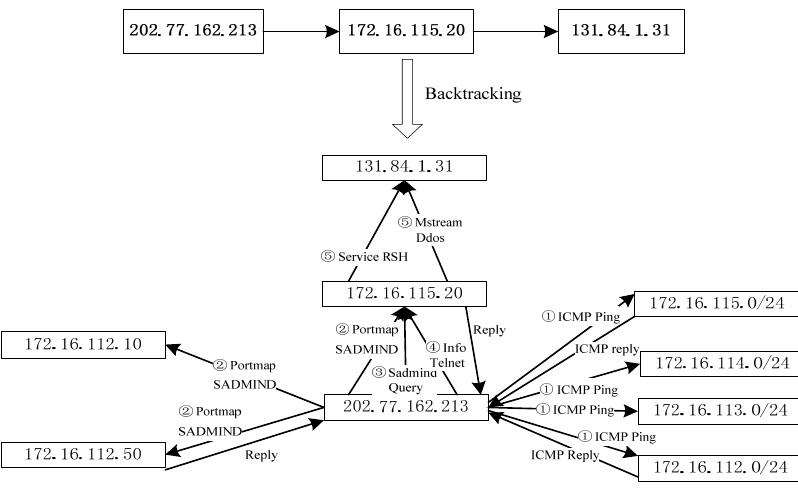
Figure 7. LLDOS 1.0 Dataset Evidence Graph (Omission of DDoS Attacks).